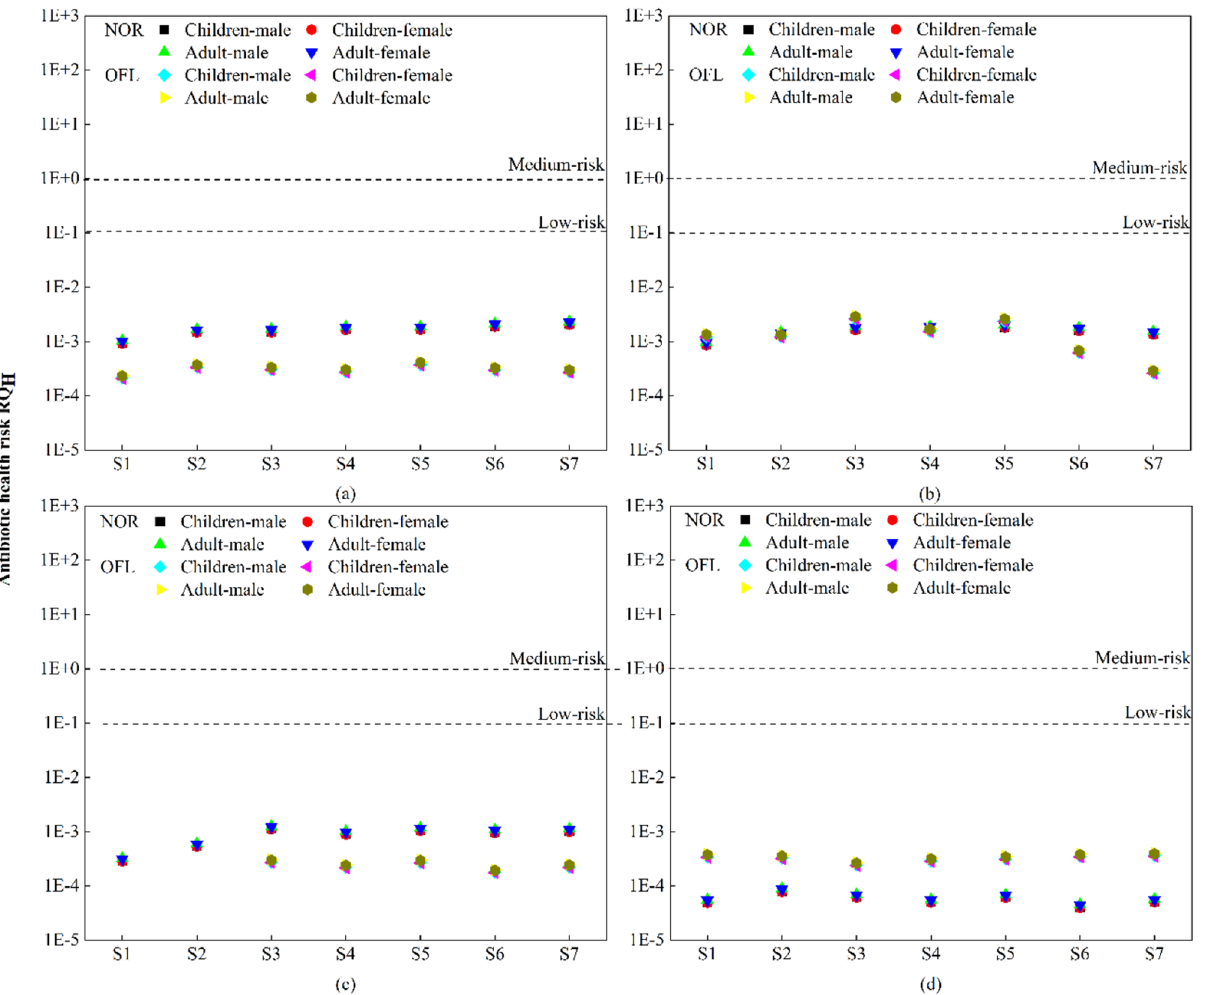
Figure 6. Risk assessment of antibiotic human health. ( a – d ) are human health risk assessments for NOR and OFL in June, August, October and December. RQ H > 1 is high risk, 0.1 < RQ H < 1 is medium risk, RQ H < 0.1 is low